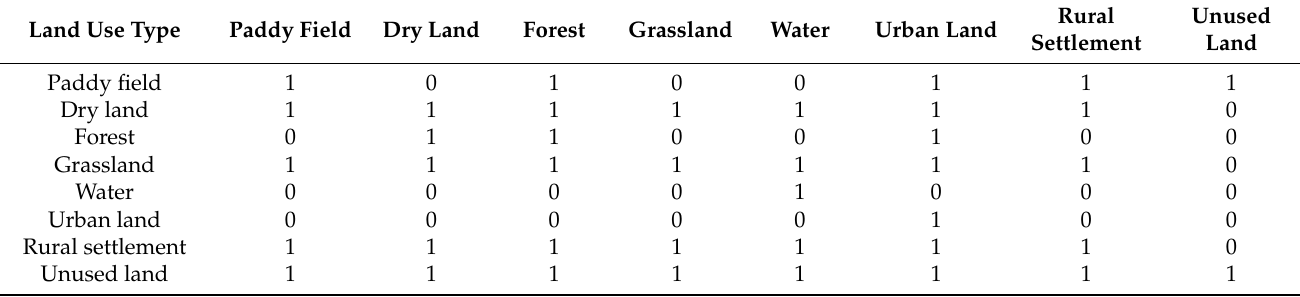
Table A4. Land use conversion cost matrix of MEC scenario.